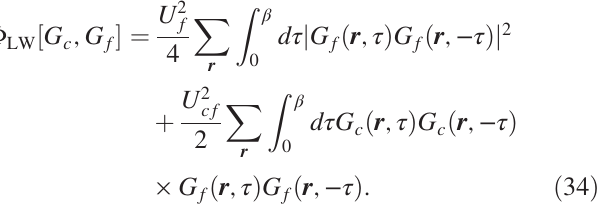
FIG. 5. (a) Diagram for the computation of σ lines represent current operators, and solid black (red) lines represent the full Green ’ s functions G self-consistent equation for the current